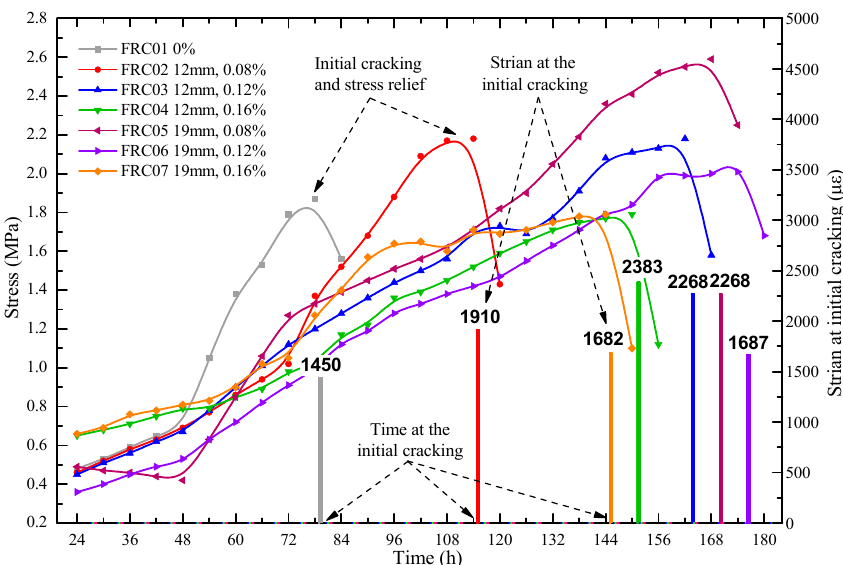
Figure 13. Time and strain at the initial cracking of the concrete specimens and stress of the steel ring before cracking.